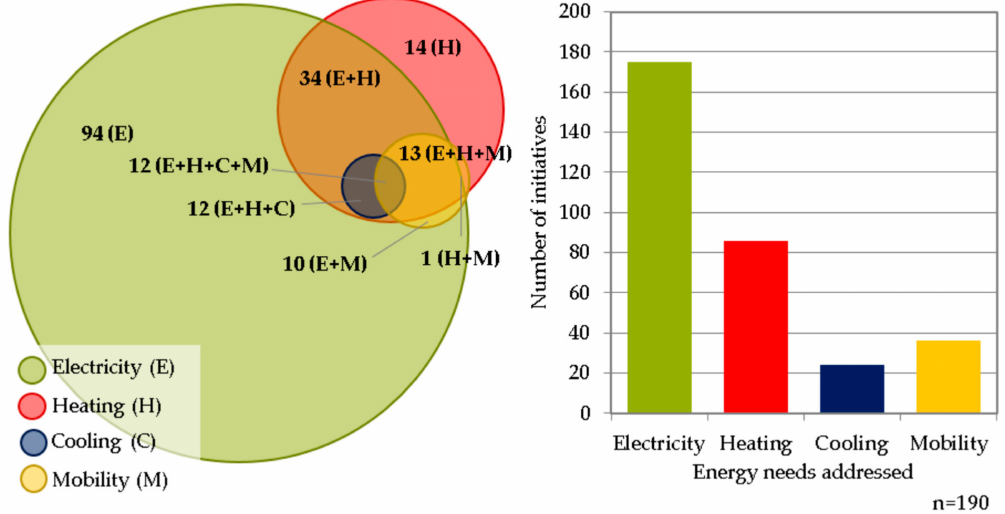
Figure 3. Energy needs addressed by initiative including combined